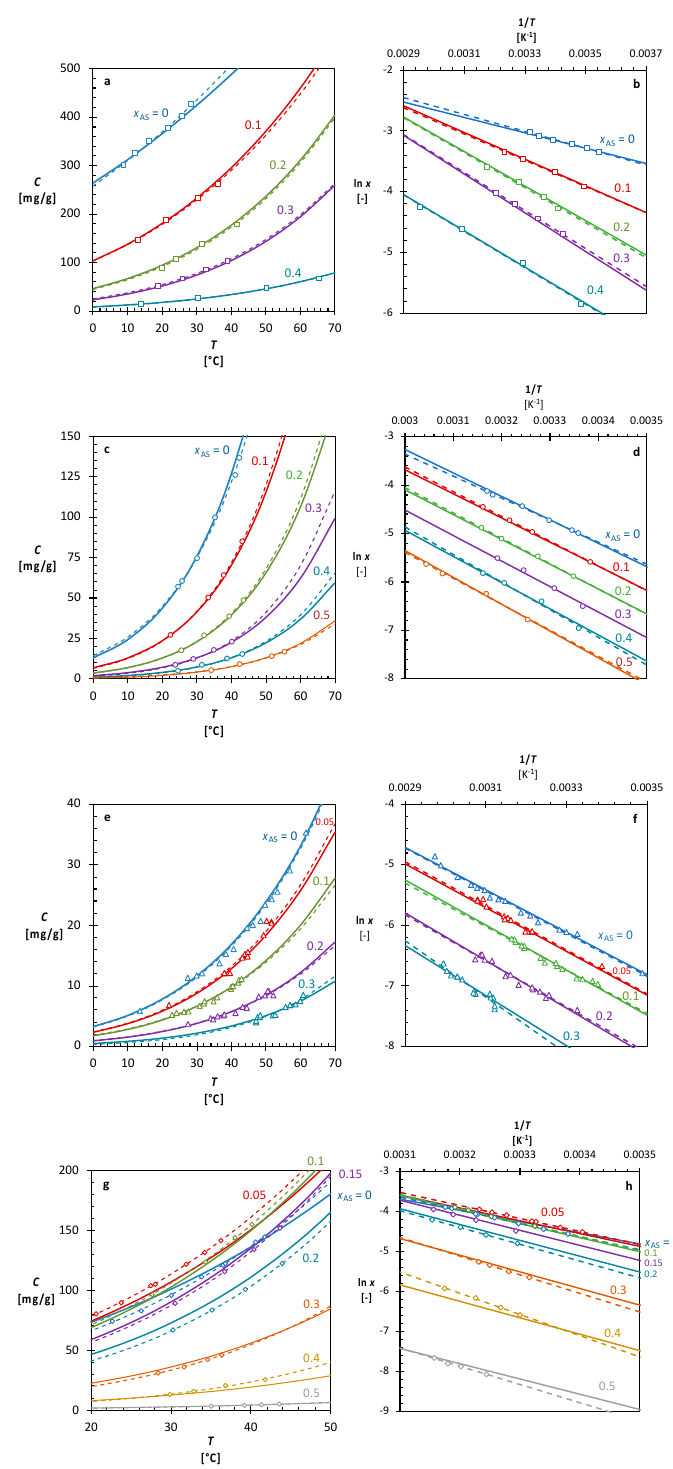
Figure 4. Concentration–temperature (left) and lnx—1/T (right) diagrams of: ( a , b ). ( ■ ) NaBrO 3 in water–ethanol, ( c , d ). ( ● ) ASN in water–ethanol, ( e , f ). ( ▲ ) MFA in ethanol/water, and ( g , h ). ( ) LOV in acetone/water at various antisolvent fractions. The experimental data are represented by the markers, with the colours and labels representing the antisolvent fraction. The dashed lines give the best fit of the data at a specific antisolvent fraction to Equation (2). The solid lines represent the predicted solubility at each antisolvent fraction using the best fit of all data to Equation (4).